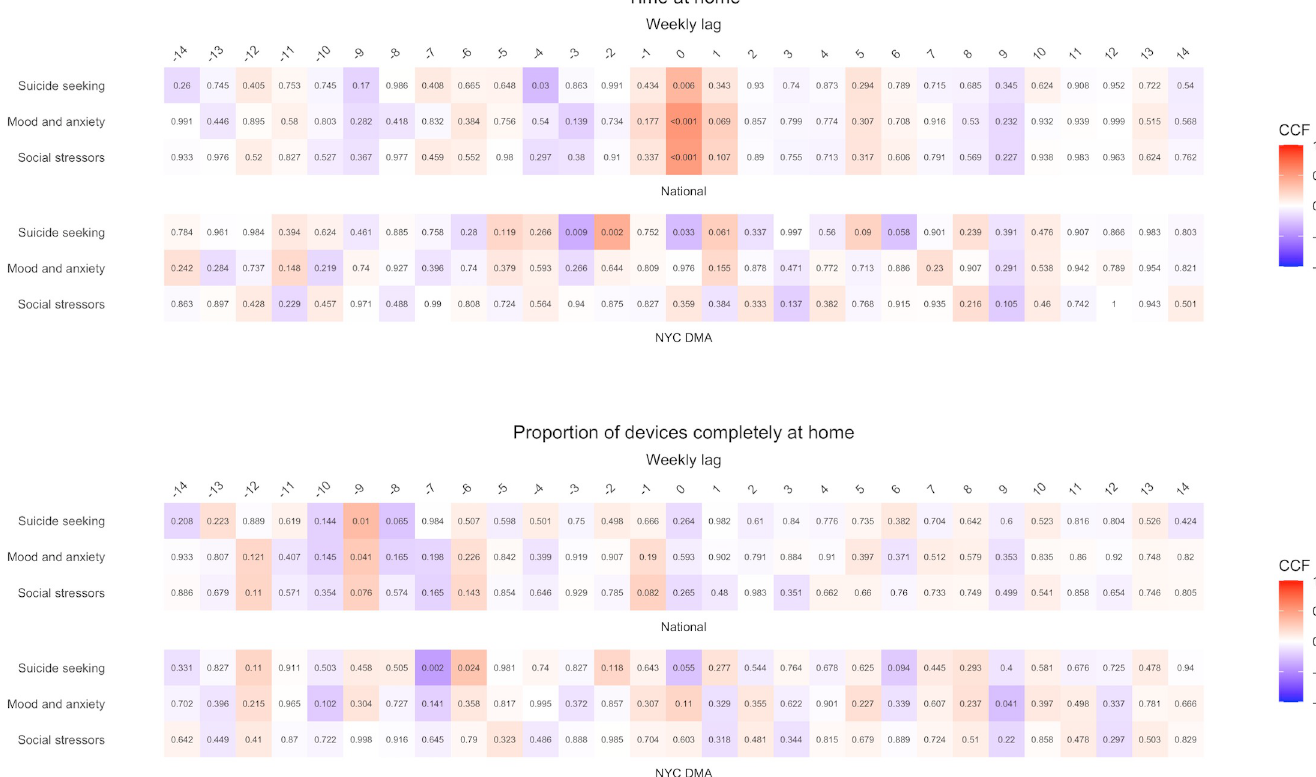
Fig 5. Heatmaps of cross-correlation coefficients for mobility indicators and Google Health Trends search volumes for suicide seeking, mood and anxiety, and social stressor terms nationally and in the NYC DMA: 2020–2021. P-values listed within cells. Note on interpretation: A cross-correlation coefficient at a negative weekly lag indicates that changes in the explanatory time series lead changes in the dependent time series that number of weeks later. A cross-correlation coefficient at a positive weekly lag indicates that changes in the dependent time series lead changes in the explanatory time series that number of weeks later. Correlations at the 0-week lag suggest that changes in both time series were concurrent. A positive cross-correlation coefficient indicates that there is a direct correlation between the time series and a negative cross-correlation coefficient indicates that there is an inverse correlation between the time